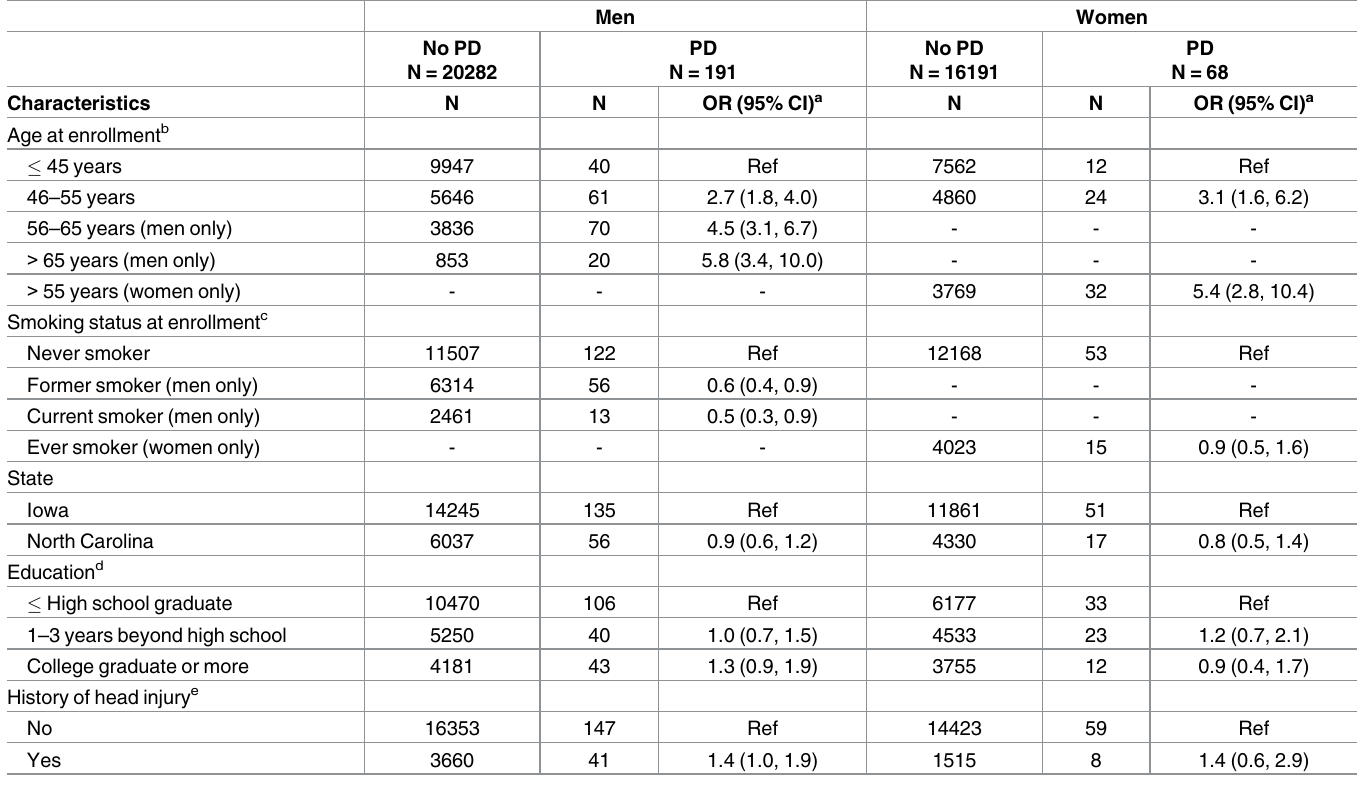
Table 1. Baseline characteristics of participants of the Agricultural Health